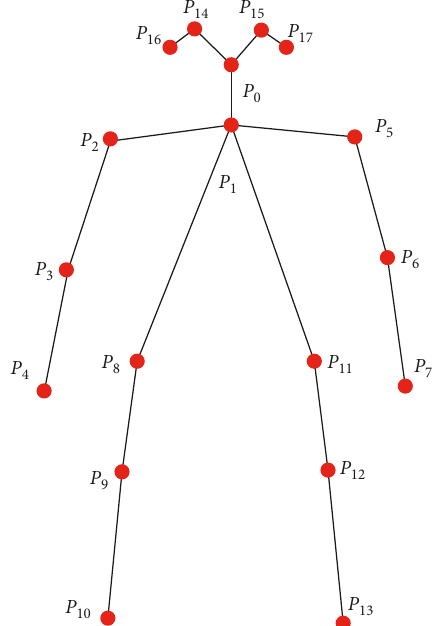
Figure 2: Key points of the human